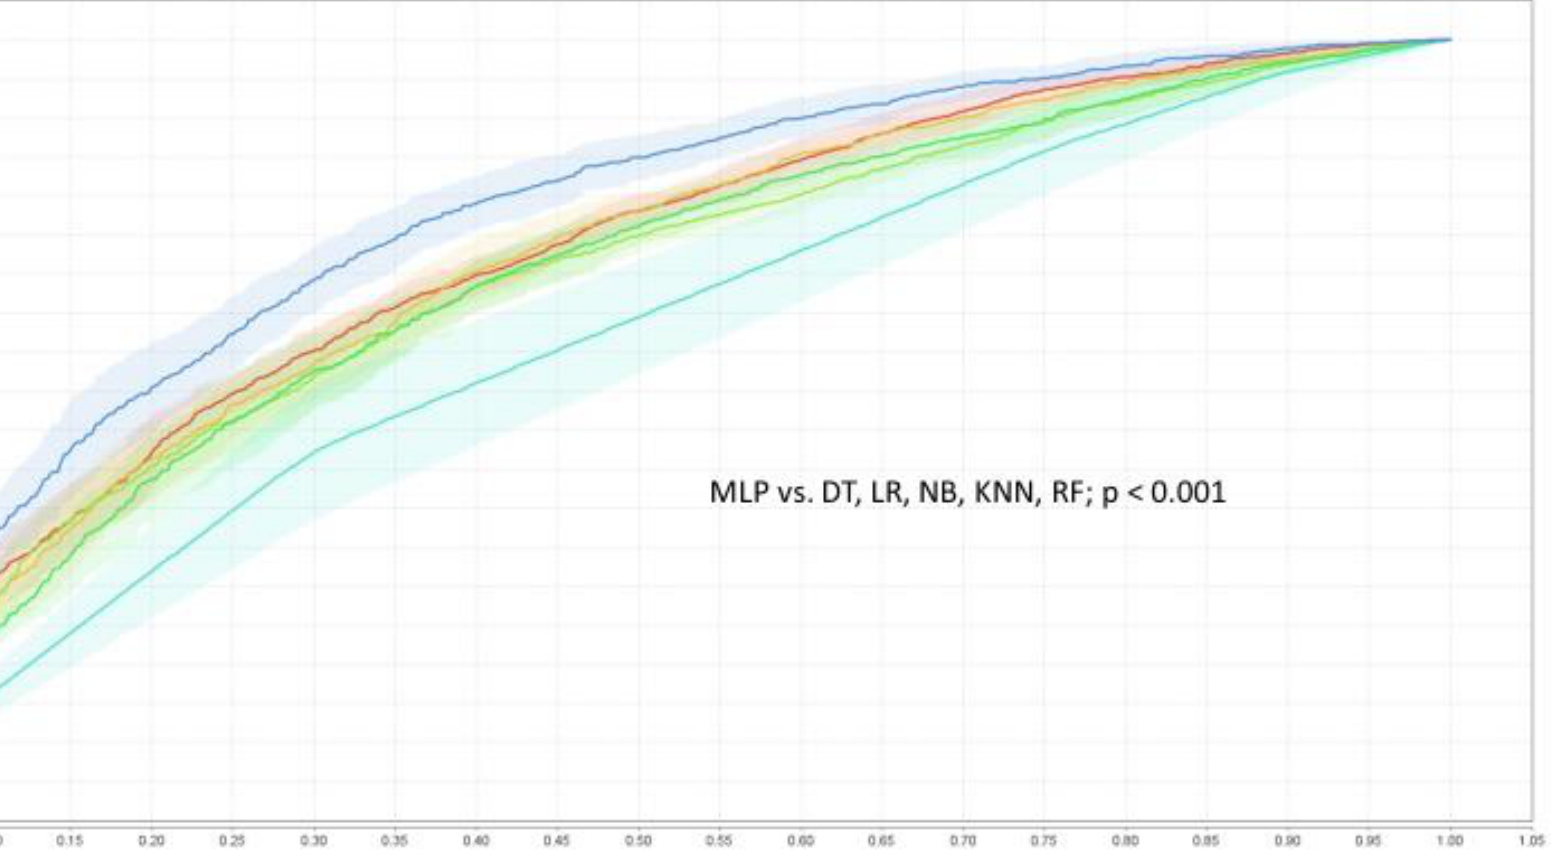
Figure 5. ROC curves of the classifiers detecting of primary outcome when DBP was included as the risk factor. DT — decision tree , KNN — k-nearest neighbor classifier dom forest .